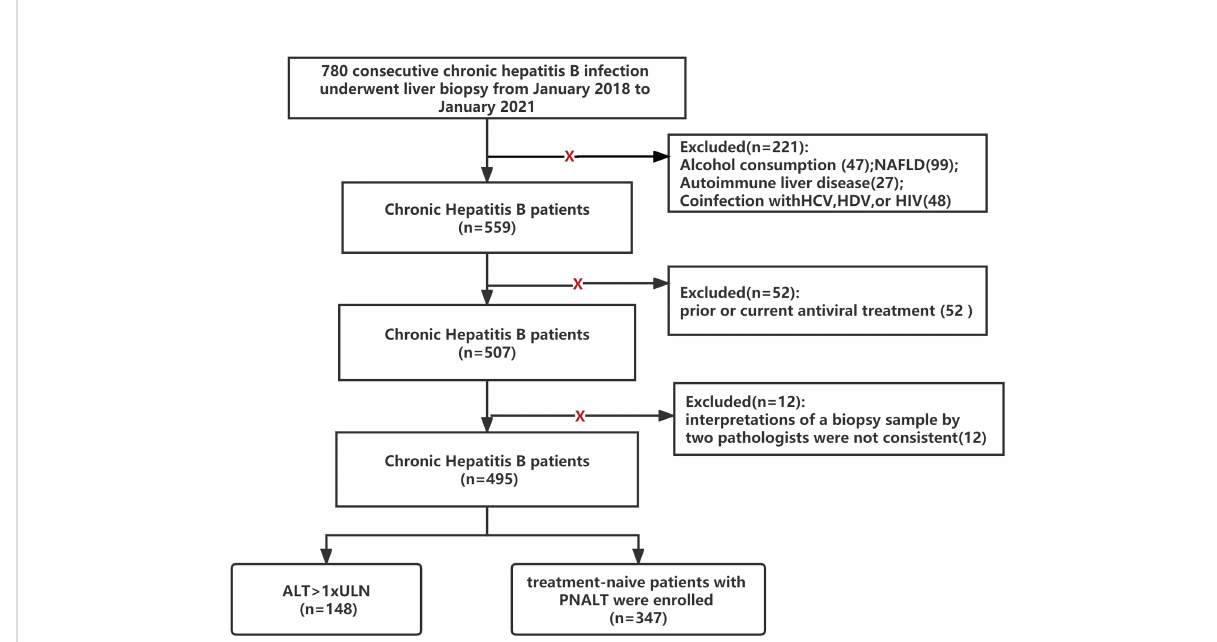
FIGURE 1 Flowchart of the study design (NAFLD, nonalcoholic fatty liver disease; HCV, hepatitis C virus; HDV, hepatitis D virus; HIV, human immunode fi ciency virus; PNALT, persistent normal ALT; ULN, <40